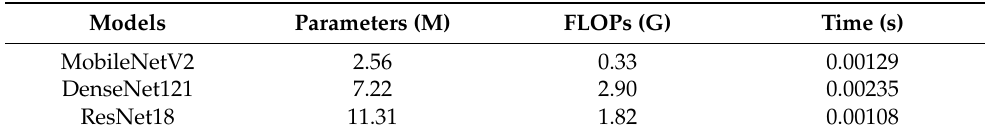
Table 4. Complexity analysis of different